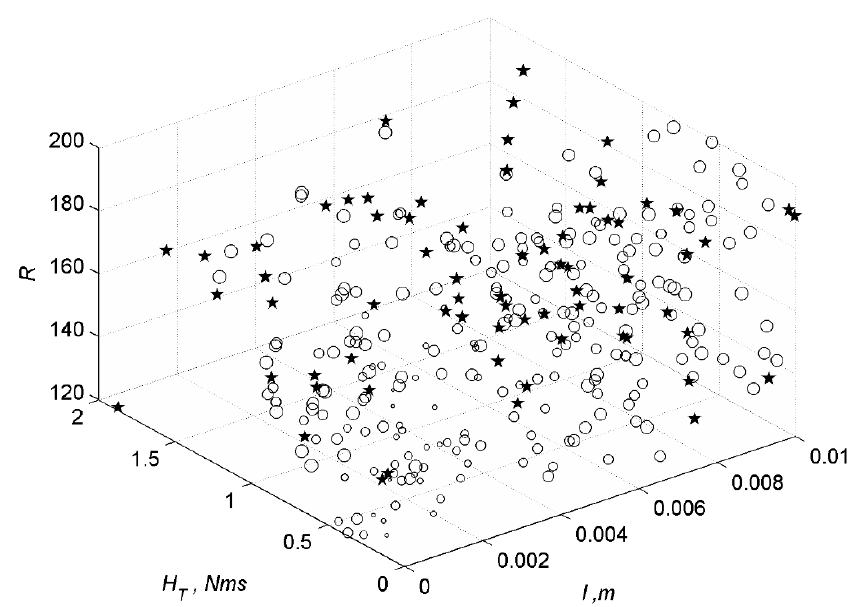
Figure 11. Random points and range of saturation of reaction wheels (bubbles means that there is no saturation and the capturing is successful, and the stars are for the capturing failure due to reaction wheels saturation).